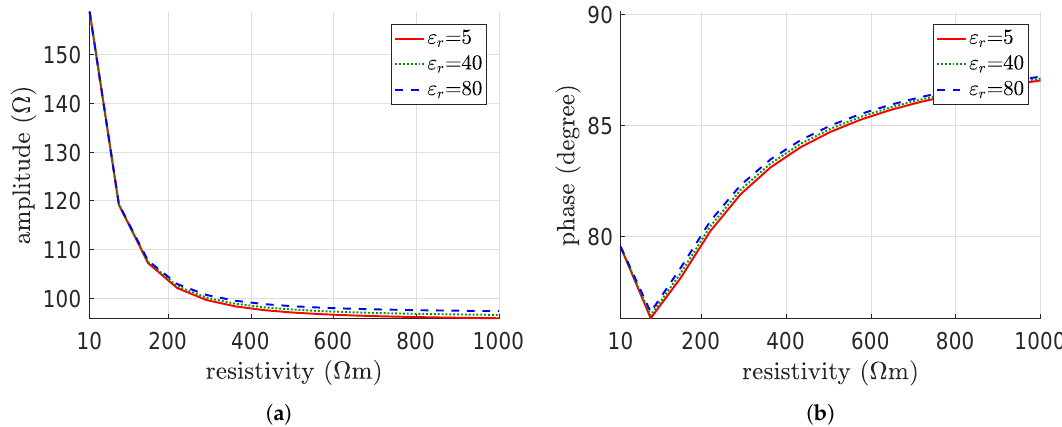
Figure 16. Equivalent impedance of the embedded coil ( Mod2 ) at 85 kHz for a concrete resistivity from 10 Ω m to 1000 Ω m, parametrized for ε r equal to 5, 40, and 80. Amplitude ( a ); phase ( b ).